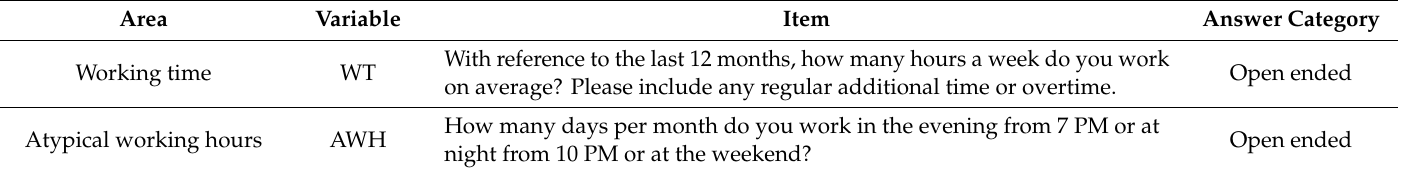
Table A3. Working time and atypical working hours.